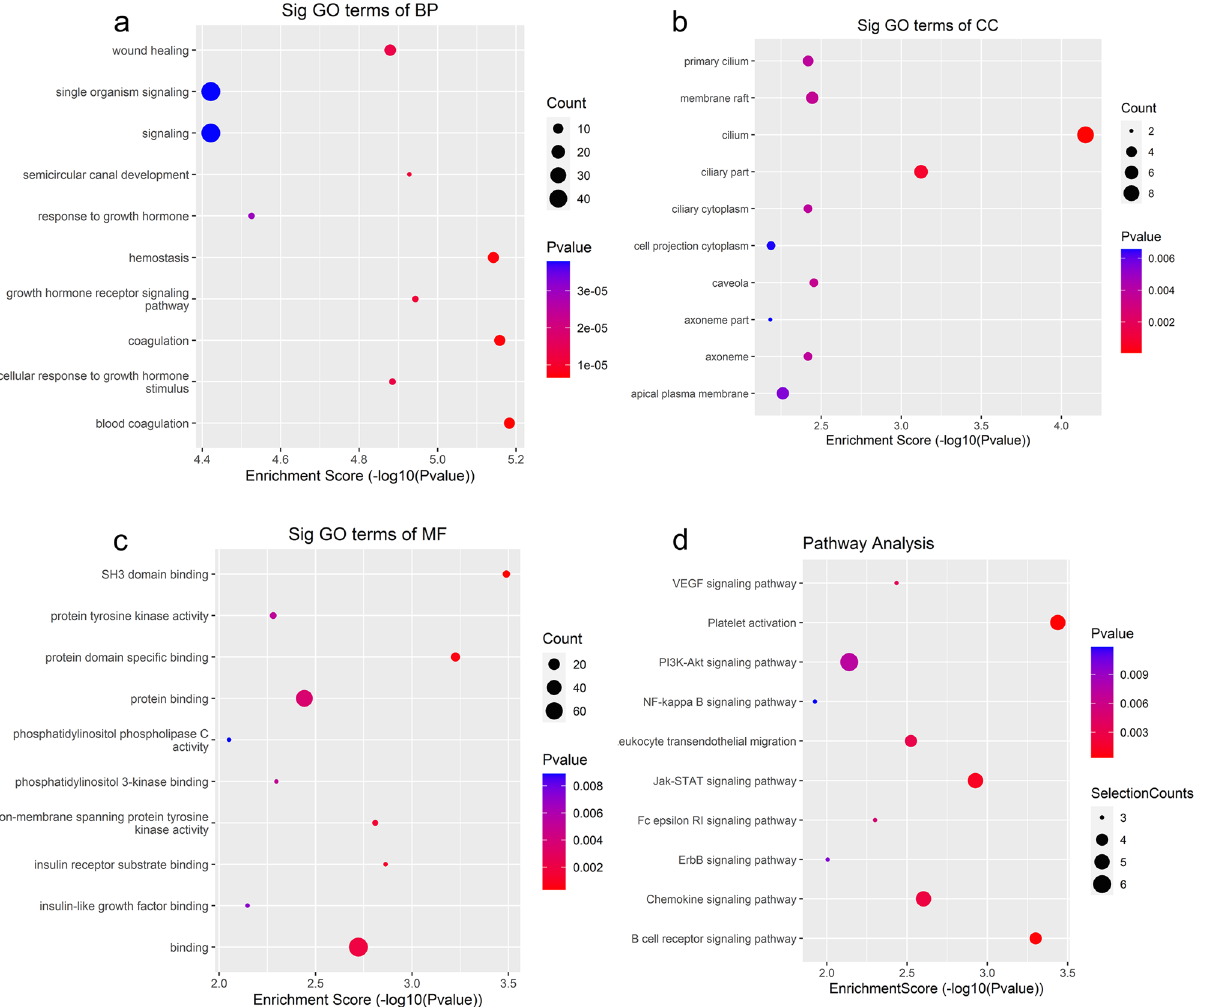
Figure 3. Results of m6A RNA sequencing data analysis with DAVID 6.7 software. Gene Ontology (GO) enrichment ( a – c ) and Kyoto Encyclopedia of Genes and Genomes (KEGG) signalling pathway ( d ) analyses for the host genes of upregulated m6A-methylated circRNAs. (BP: biological process; CC: cellular component; MF: molecular